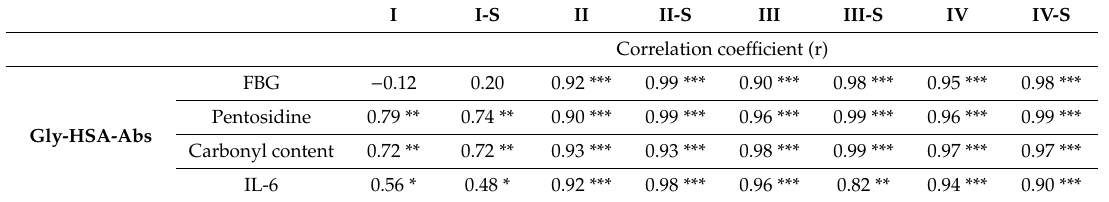
Table 4. Correlation analysis between Gly-HSA-Ab levels and serum fasting blood glucose (FBG), pentosidine, carbonyl contents, and cytokine